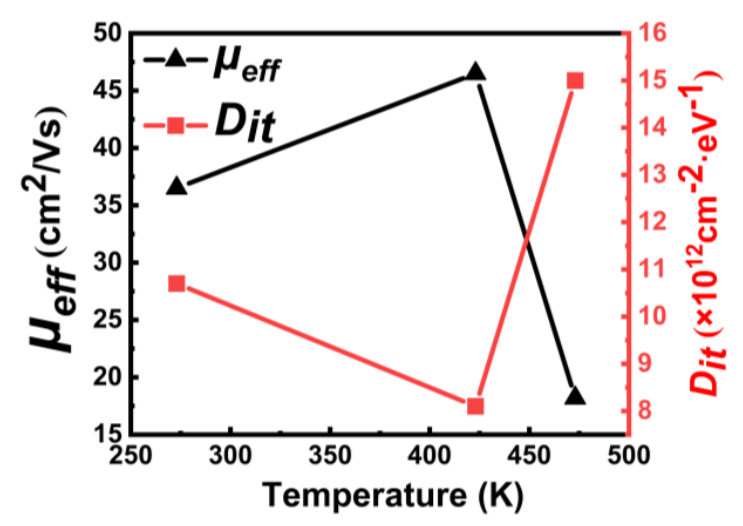
Figure 6. μ eff at V th − V GS = 2 ± 0.2 V and D it as a function of annealing temperature. Figure 6. µ eff at V th − V GS = 2 ± 0.2 V and D it as a function of annealing